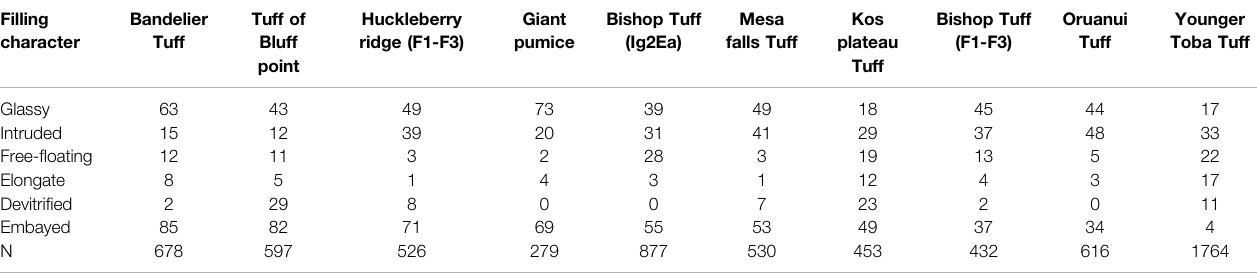
TABLE 3 | Observed bubble textural